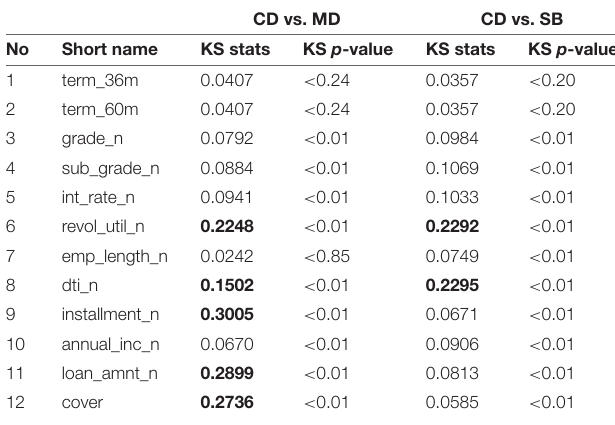
TABLE 4 | Kolmogorov-Smirnov (KS) of input